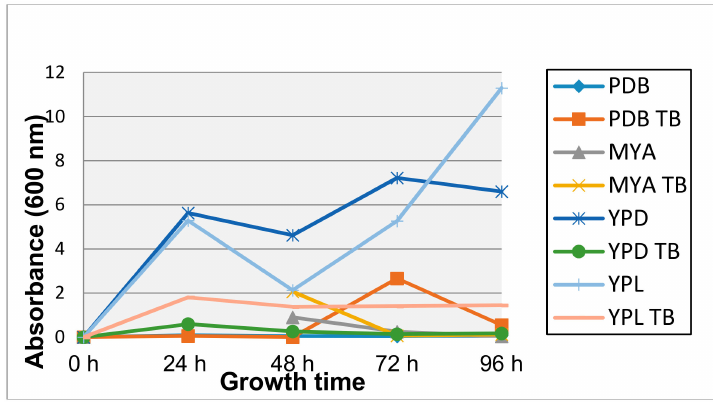
Figure 1. Growth evolution of the Candida antarctica standard strain from the CECT, in different growth media, with and without tributyrin (TB), obtained every 24 h through absorbance measurements at 600 nm.